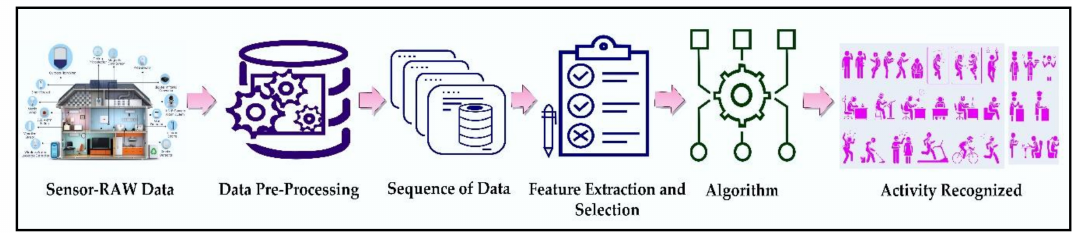
Figure 1. General Process for Activity